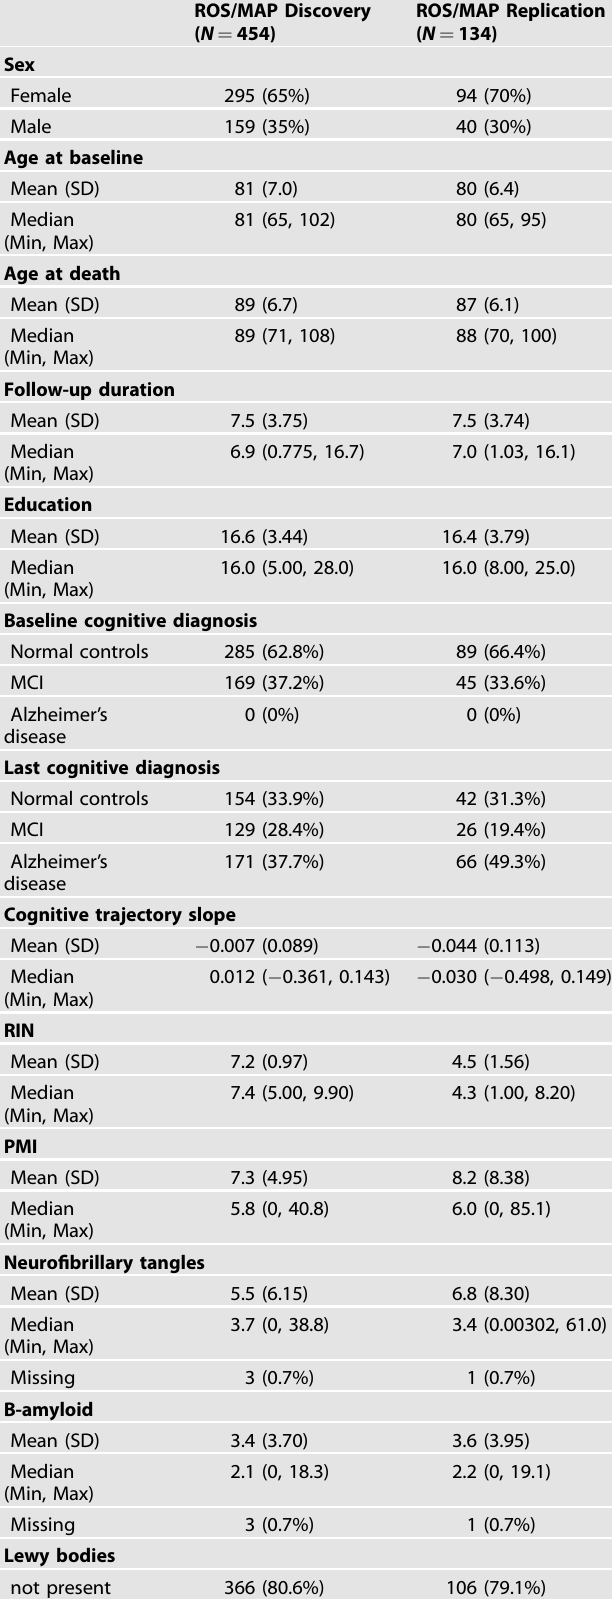
Table 1. Characteristics of the discovery and replication cohorts in the global microRNA association study of cognitive